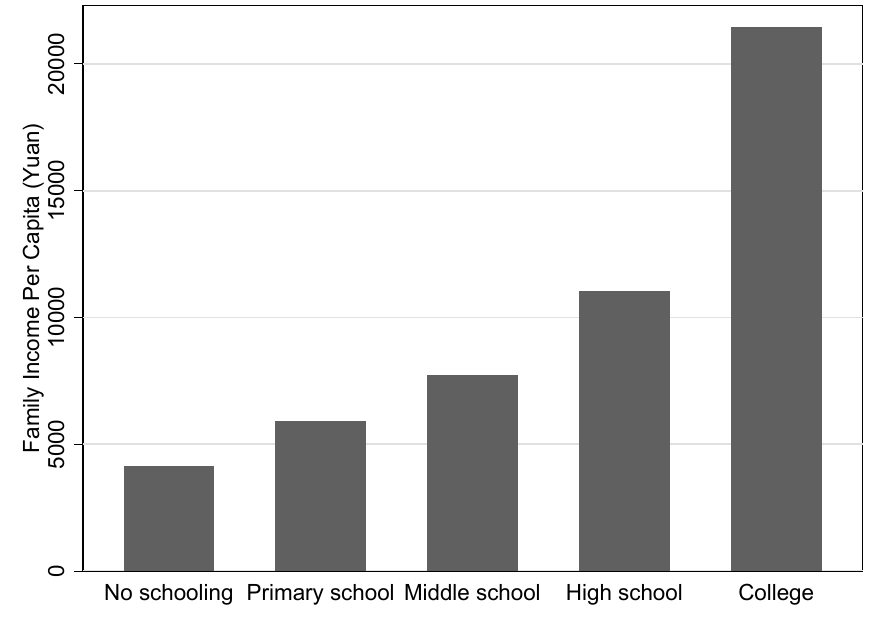
Figure A1. Family Income per capital by Maternal Education.